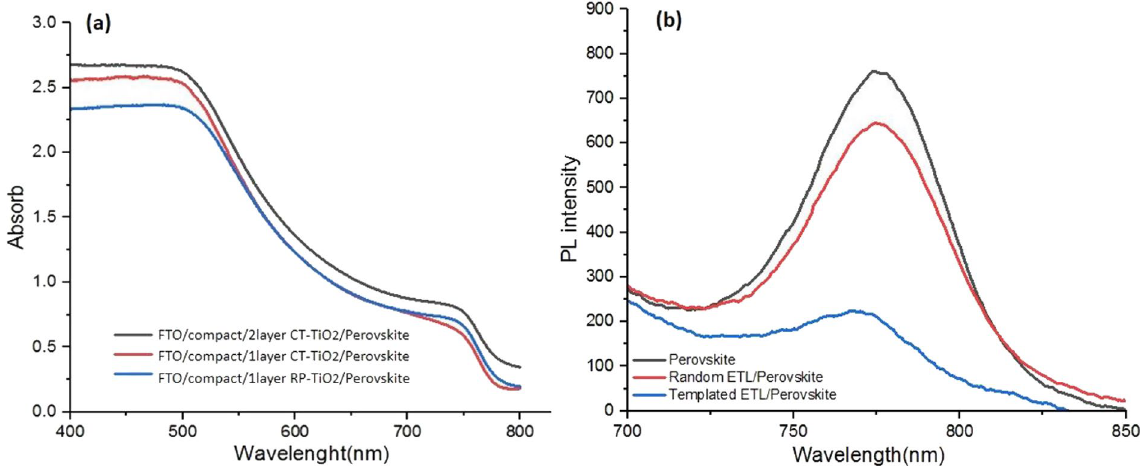
Figure 3. ( a ) The UV–Vis absorption spectra of the perovskite on different titania films, and ( b ) PL intensity for perovskite, RP-TiO 2 ETL/perovskite, and CT-TiO 2